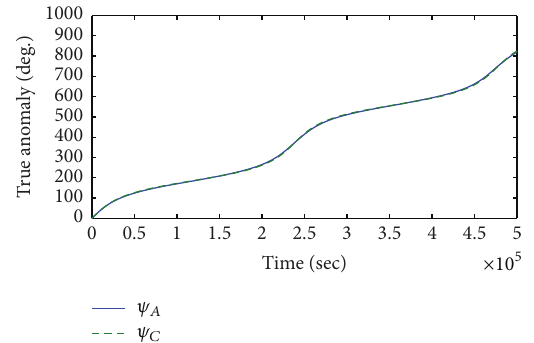
Figure 5: True anomaly as functions of time for free